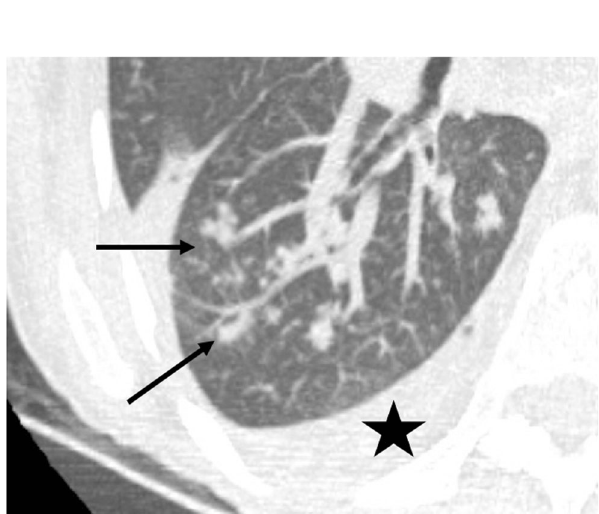
Fig. 14 Pseudomonas aeruginosa . Productive cough and high-grade fever. Dense tree-in-bud centrilobular nodules on maximal intensity projection reconstruction ( arrows ) and pleural effusion ( star ). Pseudomonas aeruginosa was confirmed by sputum culture